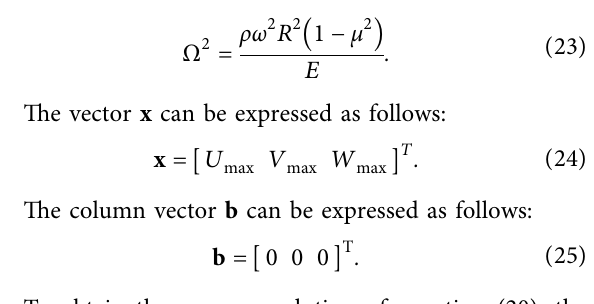
radial deformation coefficient w ∗ � 1.0. The diameter of index circle of flexspline is 84 mm, the diameter of root circle is 83 mm, and the diameter of addendum circle is 84.6